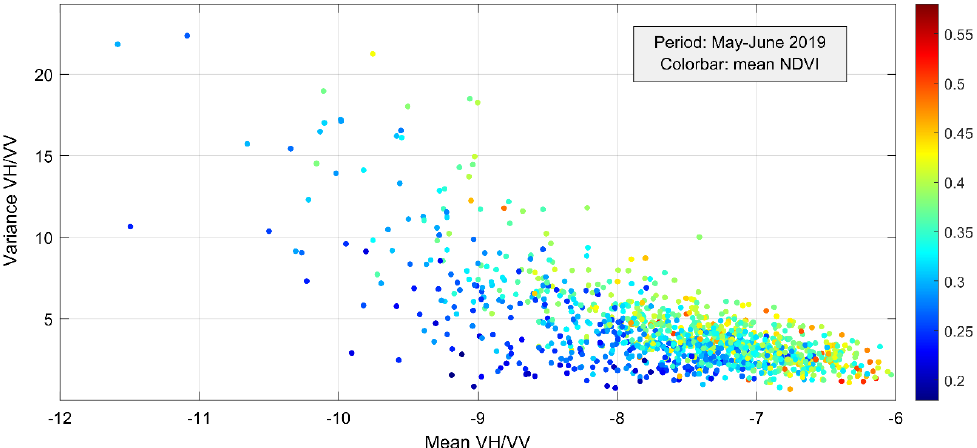
Figure 5. Comparison of radar backscattering mean and variance during the initial period of maize growth. Each point represents a maize field during the period from May to June, colored according to the mean NDVI for the same period.